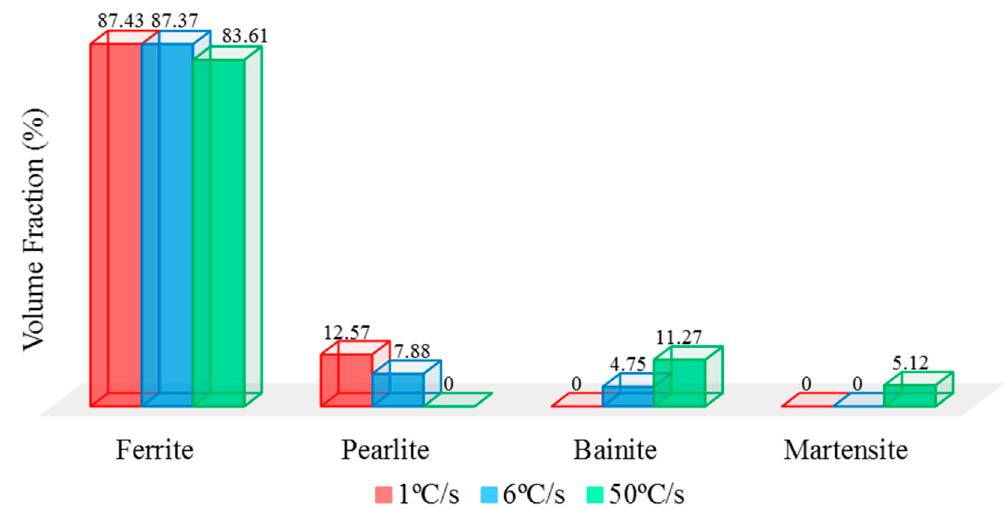
Figure 7. Comparison of volume fraction for generated phase as the effect of different quenching rate parameter on carbon steel samples.